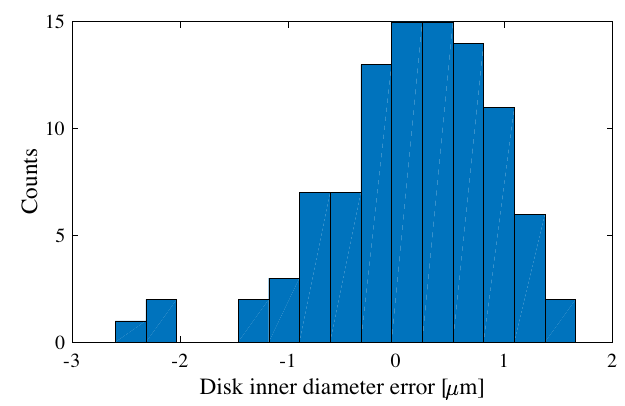
FIG. 20. Histogram of the errors on the inner cup diameter for cups produced for the TDS